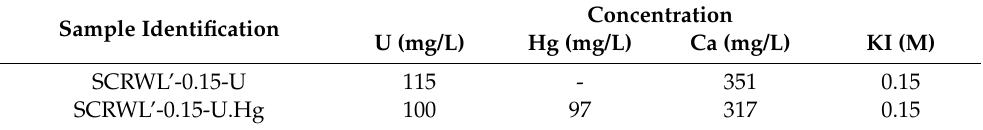
Table 4. Composition of SCRW’ leaching